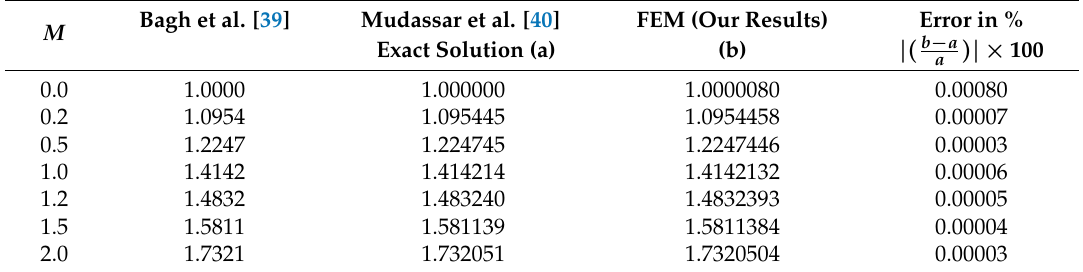
Table 4. The coefficient of skin friction in comparison with different values of magnetic parameter M .